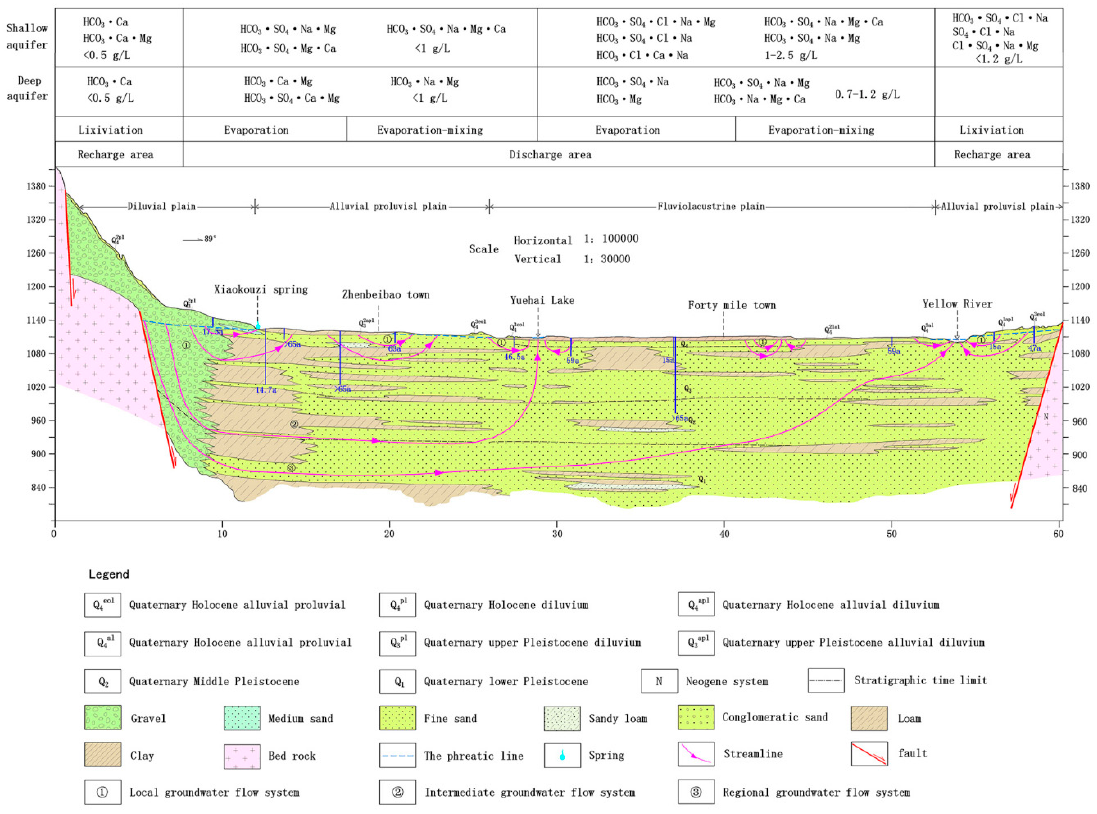
Figure 4. Hydrogeological structure and SW–GW interaction model in Profile 1.